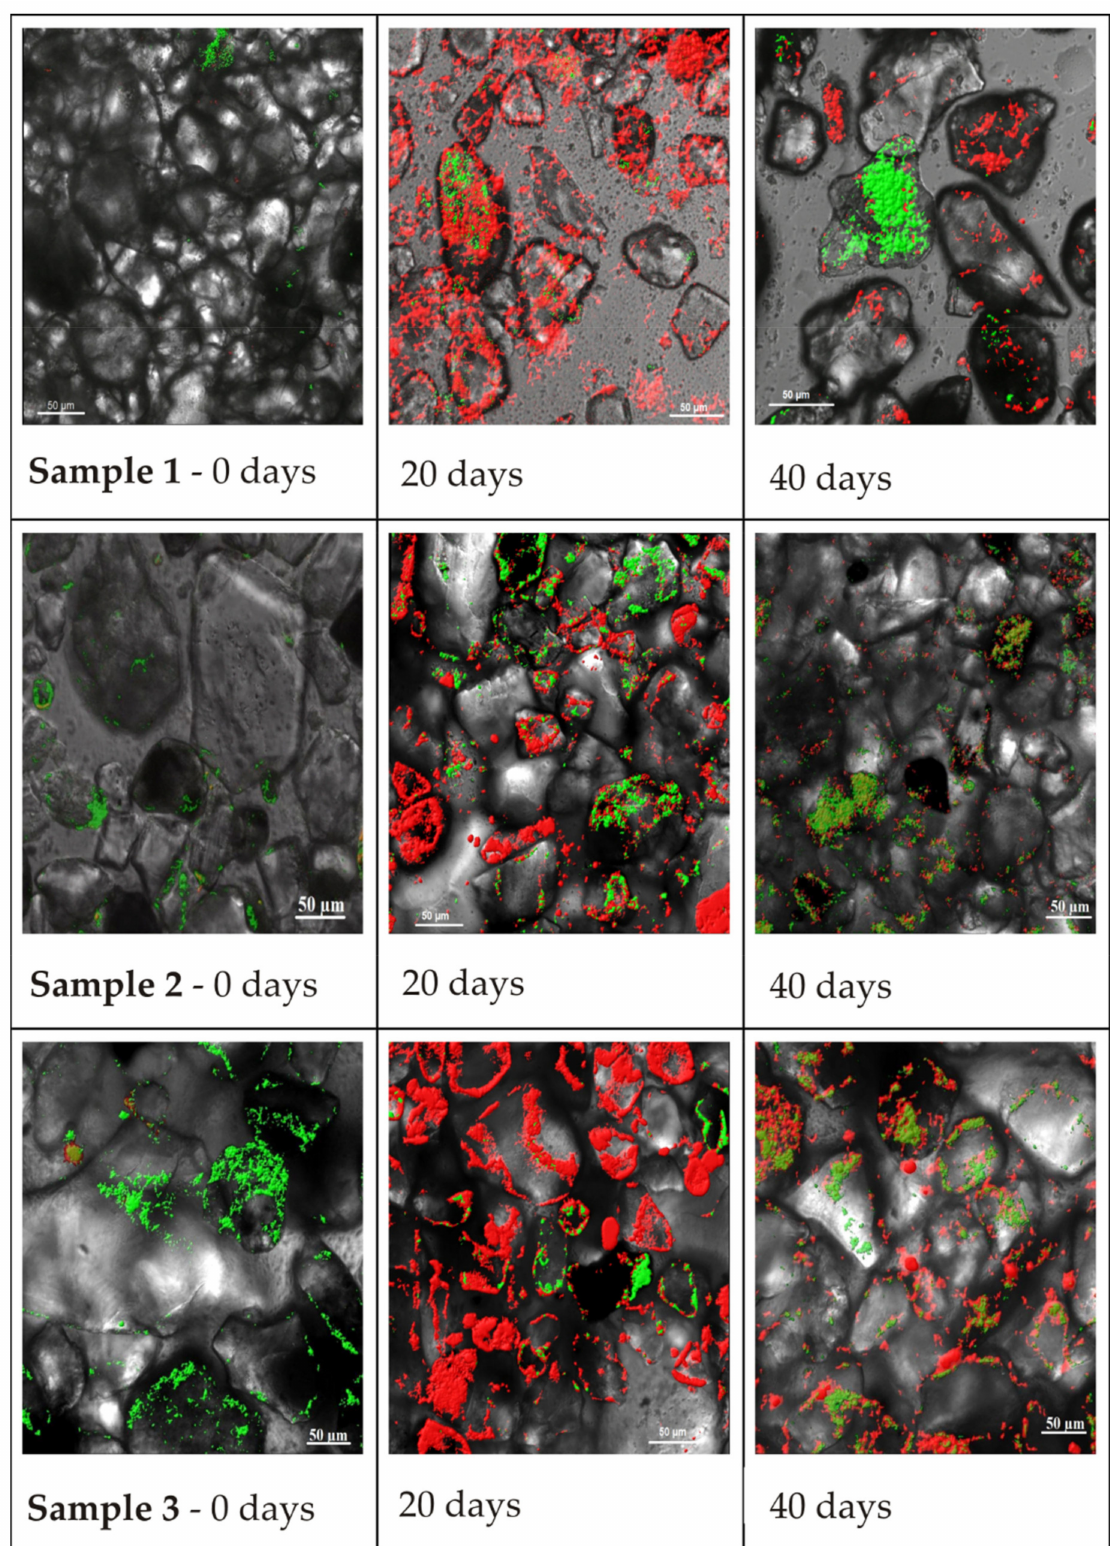
Figure 4. Microphotographs of biofilms on soil samples from boreholes 1, 2, and 3 on days 0, 20, and 40. Cellular nucleic acids have a green colour, and biofilm matrix sugars have a red